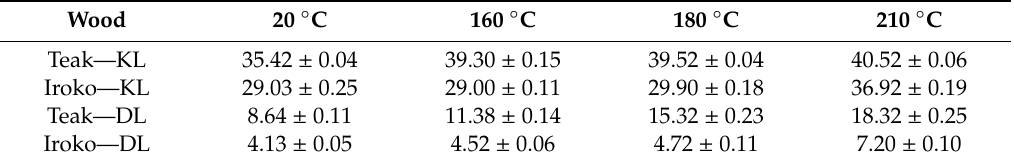
Table 1. Klason and dioxane lignin yields from untreated and thermally treated tropical wood species (mean ± SD, % odw).